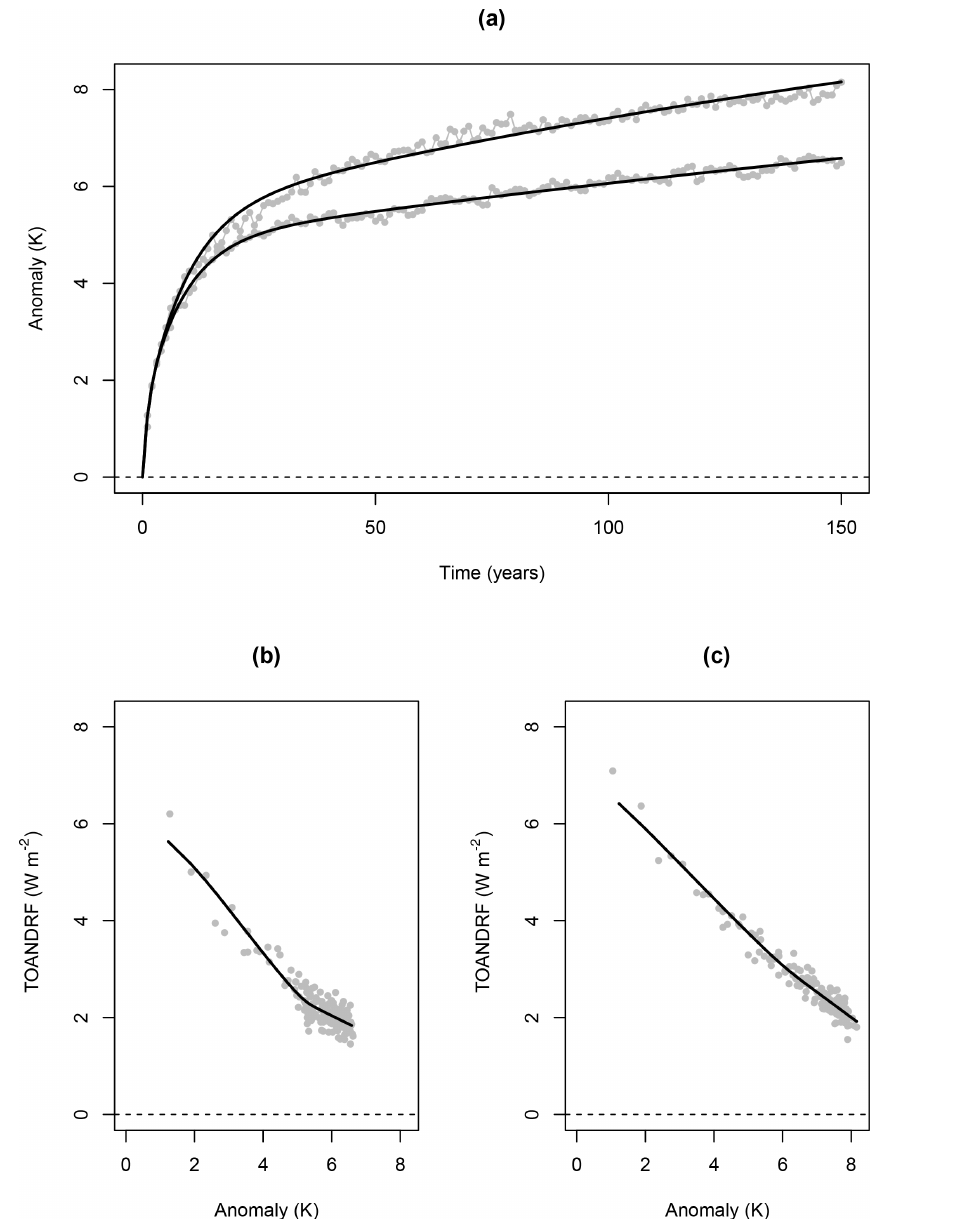
Figure 2. Three-box model fitted values. Panel (a) shows the abrupt 4 × CO 2 surface temperature responses of the HadGEM2-ES (cooler) and HadGEM3-GC3.1-LL (hotter) climate models. Anomalies are relative to the time average of surface temperature in the corresponding pre-industrial control (piControl) simulations. Panels (b) and (c) show the TOA net downward radiative flux (TOANDRF) change in the respective models as a function of surface